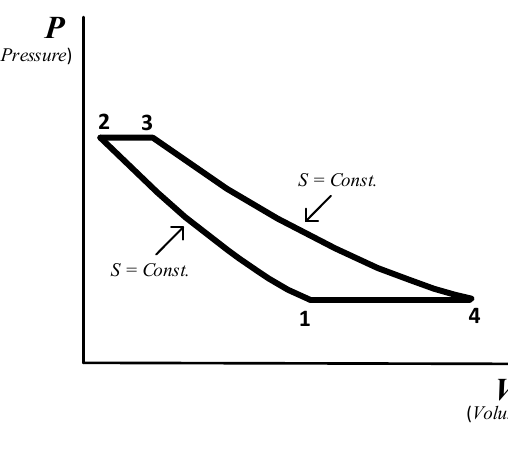
Figure 2. The air-standard Brayton cycle.